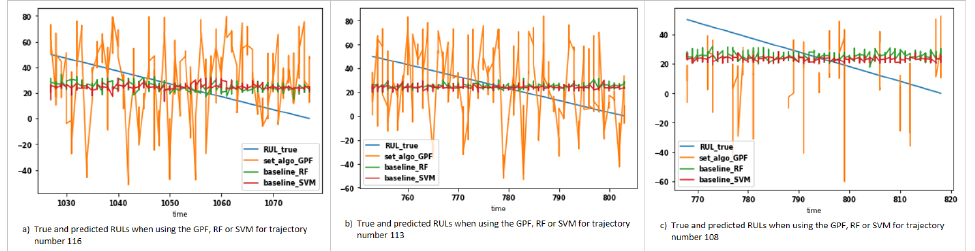
Figure 16. True and predicted values for three different trajectories of the SCU test set when using the GPF, RF, and SVM (cut 50 FC before failure).